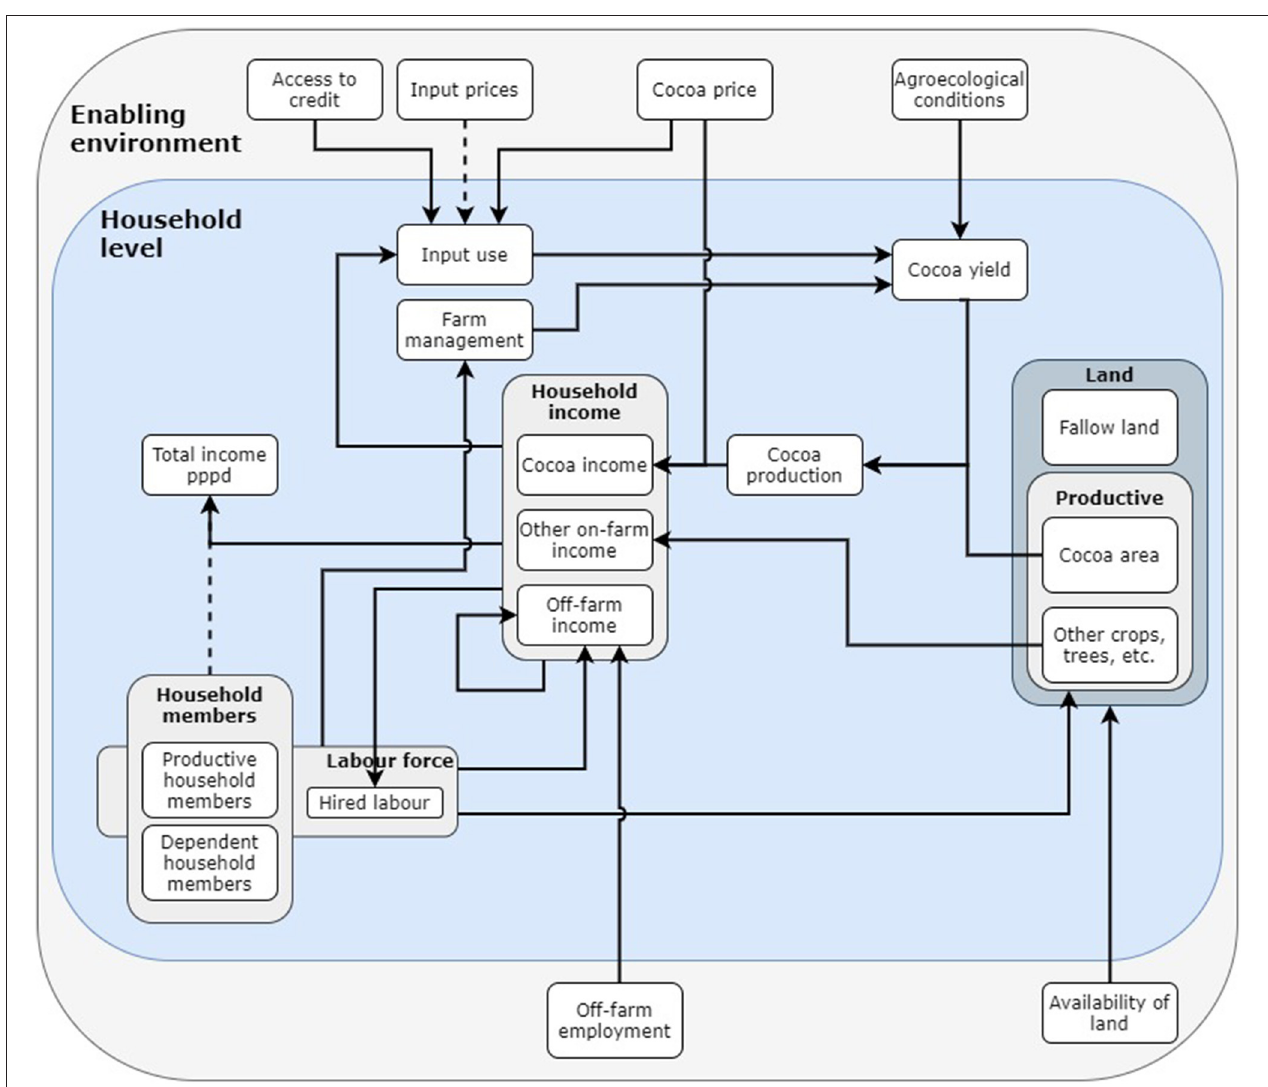
FIGURE 1 | Conceptual causal diagram of important variables related to the income of cocoa producing households. Dashed arrows represent negative effects, continuous arrows positive